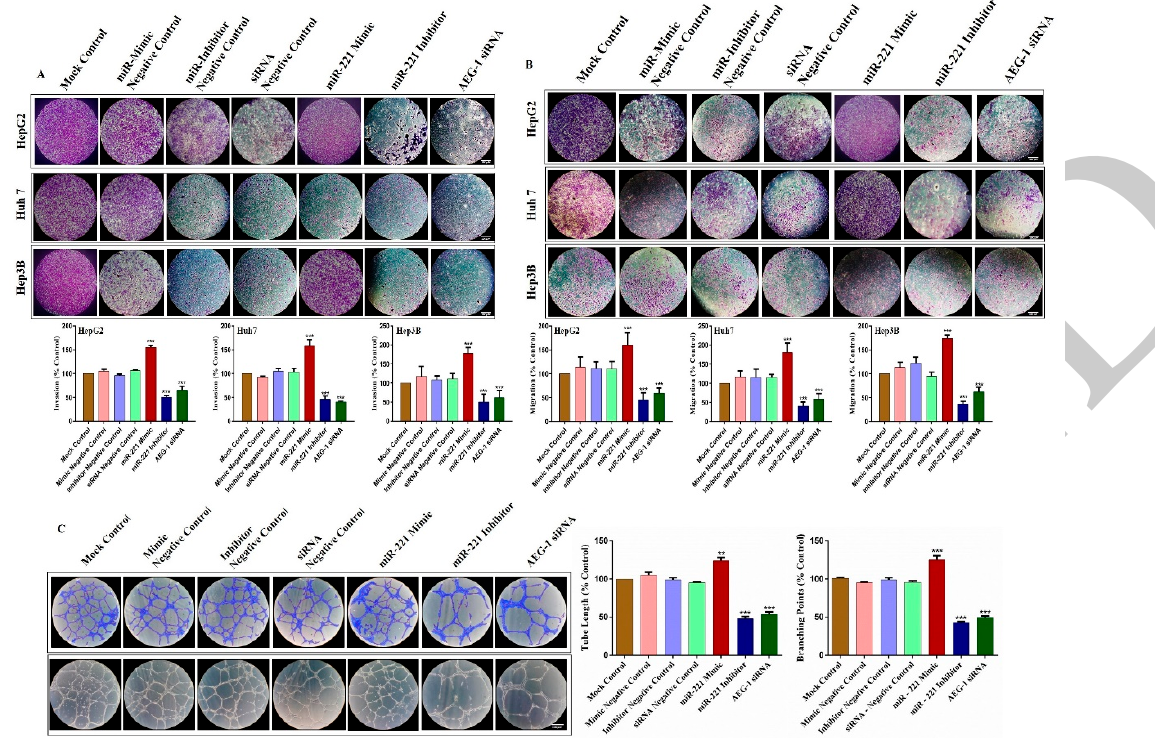
their negative control transfected HCC cells ( D ). Error bars are presented as mean ± s.d. and ** p < 0.01, *** p < 0.001 compared to the negative controls.